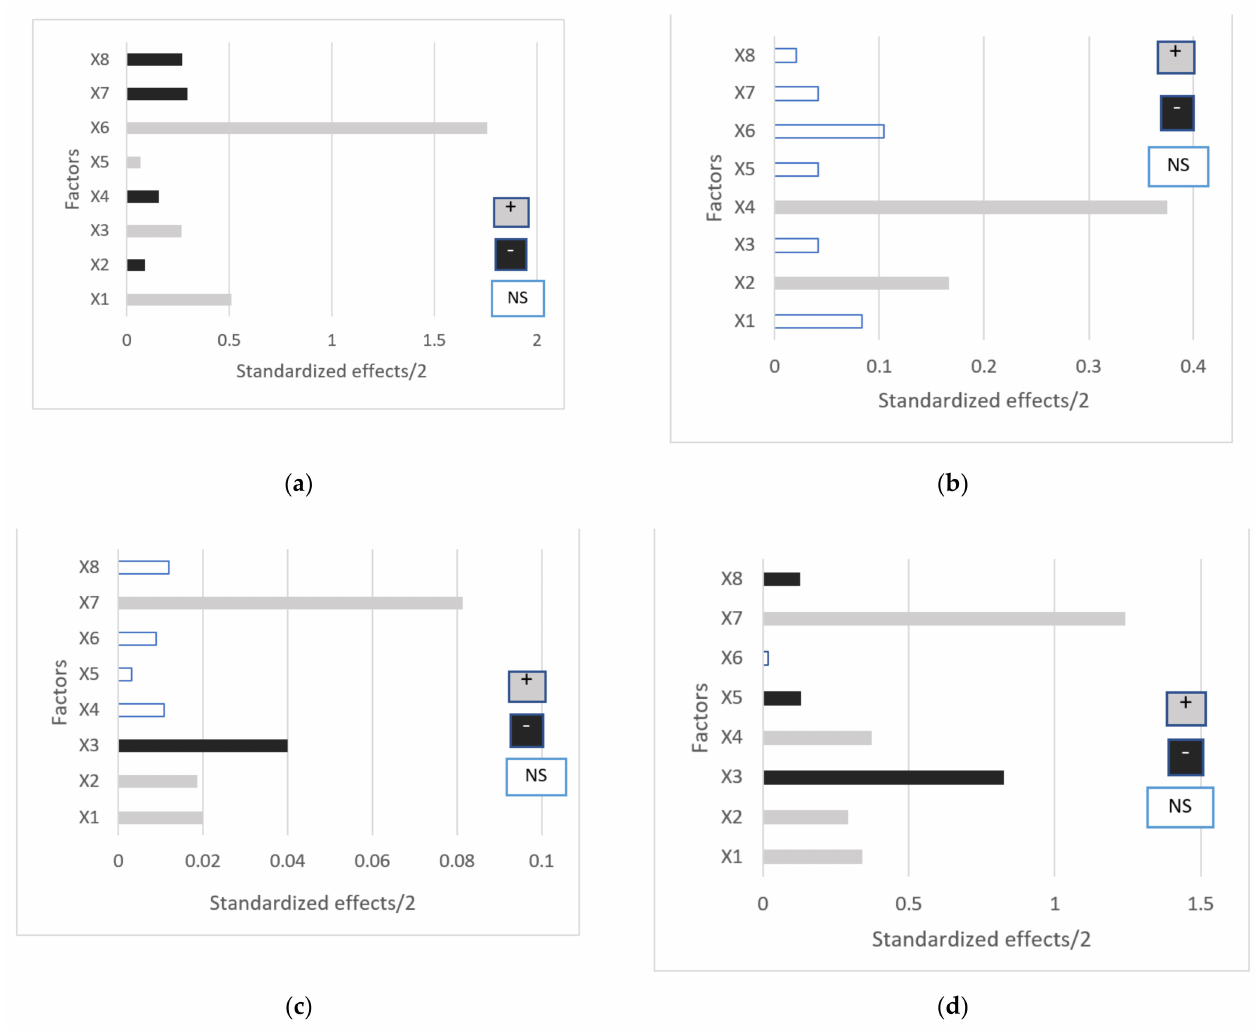
Figure 3. Pareto charts of half effects corresponding to: ( a ) gel viscosity; ( b ) pH; ( c ) in vitro Curcumin permeation; ( d ) in vitro Curcumin release. X1: [Pol] ( − 1 vs. +1); X2: Ratio ( − 1 vs. +1); X3: [Cur] ( − 1 vs. +1); X4: Tp ( − 1 vs. +1); X5: [Pol] (+1, − 1 vs. 0). X6: Tp ( − 1, +1 vs. 0); X7: Ratio ( − 1, +1 vs. 0); X8: [Cur] ( − 1, +1 vs.